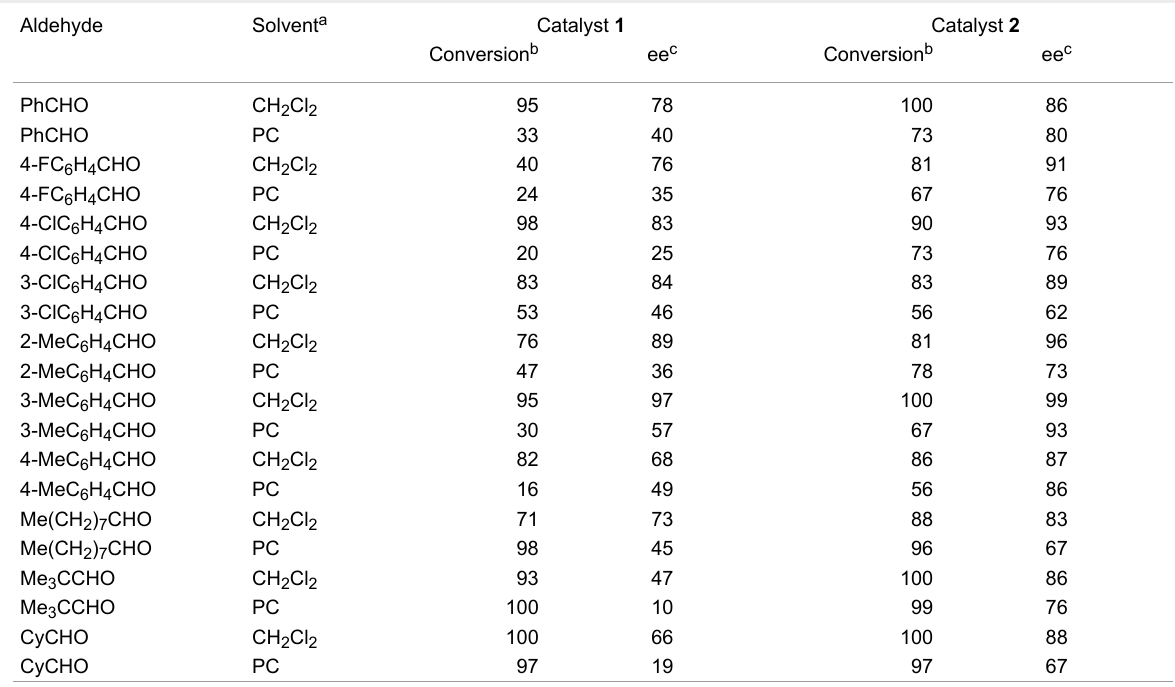
Table 1: Influence of solvent on cyanohydrin synthesis using catalysts 1 and 2